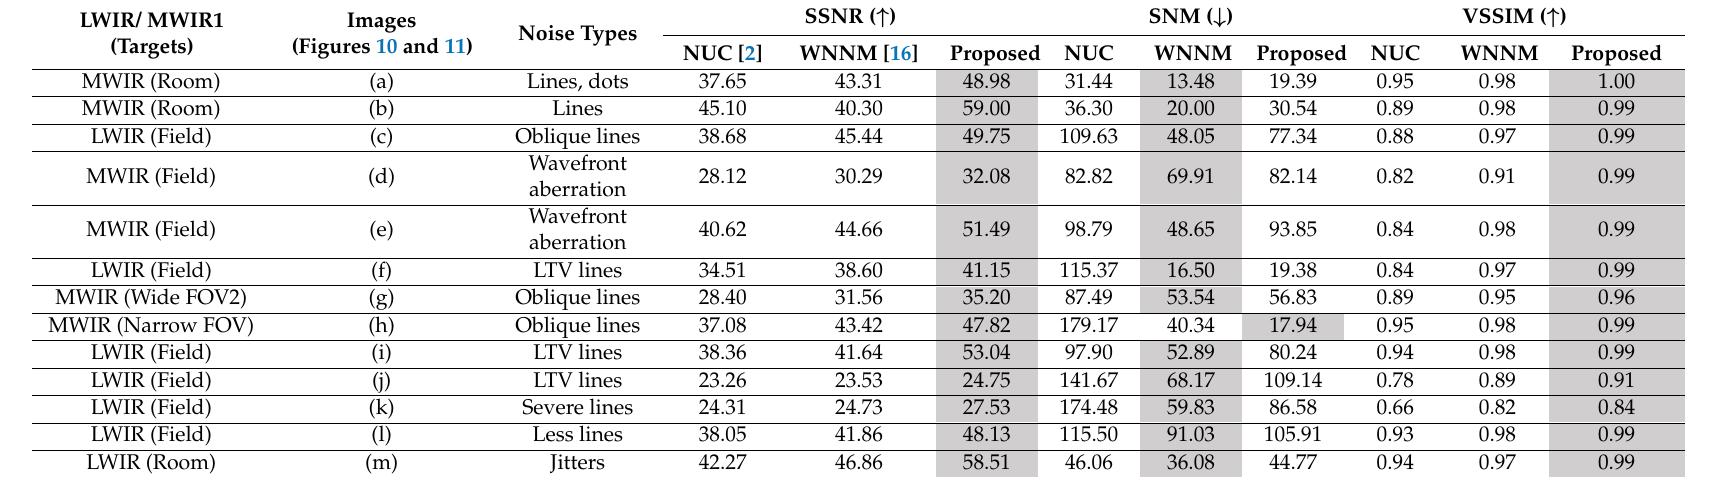
Table 3. Quantitative measurement values comparing NUC and WNNM methods.